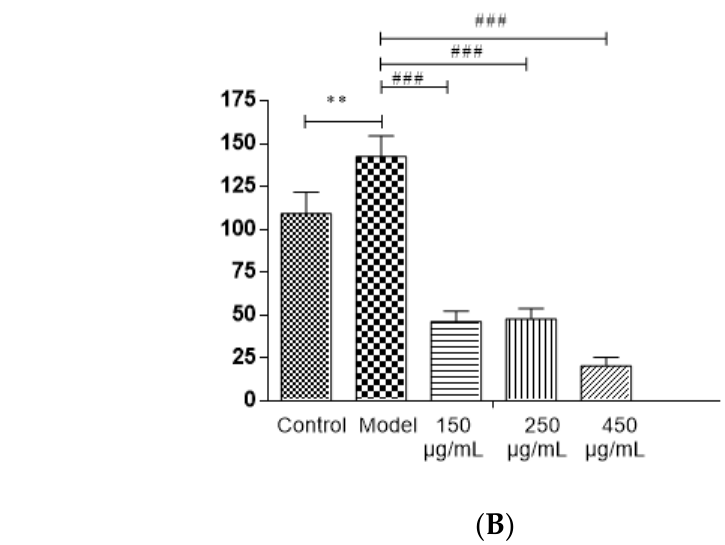
Figure 7. The detection of ROS levels in HepG2 cells ( A , B ). Values are the mean ± standard deviation. Compared with control: **, p < 0.01. Compared with model: ### , p < 0.001.